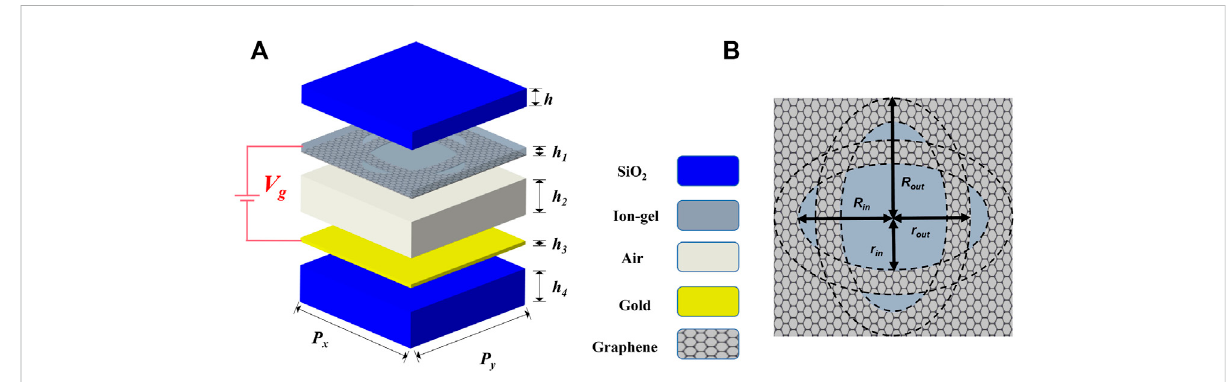
FIGURE 1 (A) Layered structure diagram of the graphene-based THz metasurface sensor. (B) Schematic diagram of the graphene microstructure,